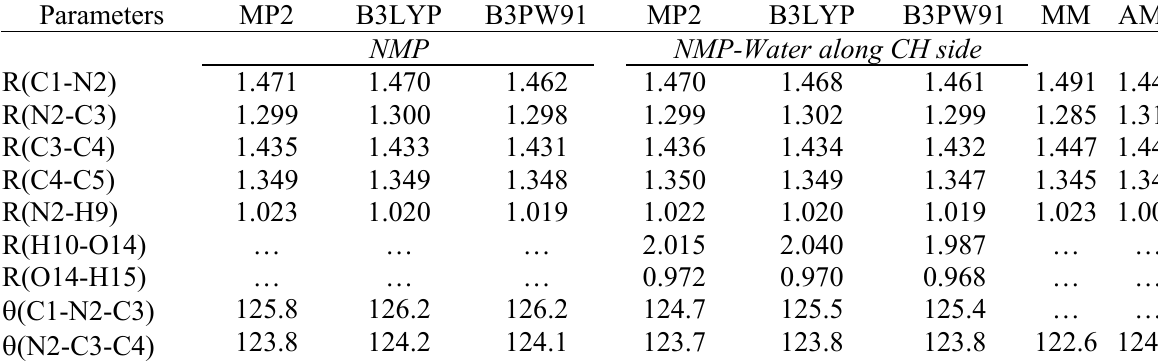
Table 1. Optimized geometrical parameters (bond length in Å, bond angle in degrees), rotational constants R , R , R (in GHz), dipole moment µ A B C energy E (in k cal/mol), chemical potential µ (in eV) and chemical hardness η (in eV) for NMP and int NMP-water